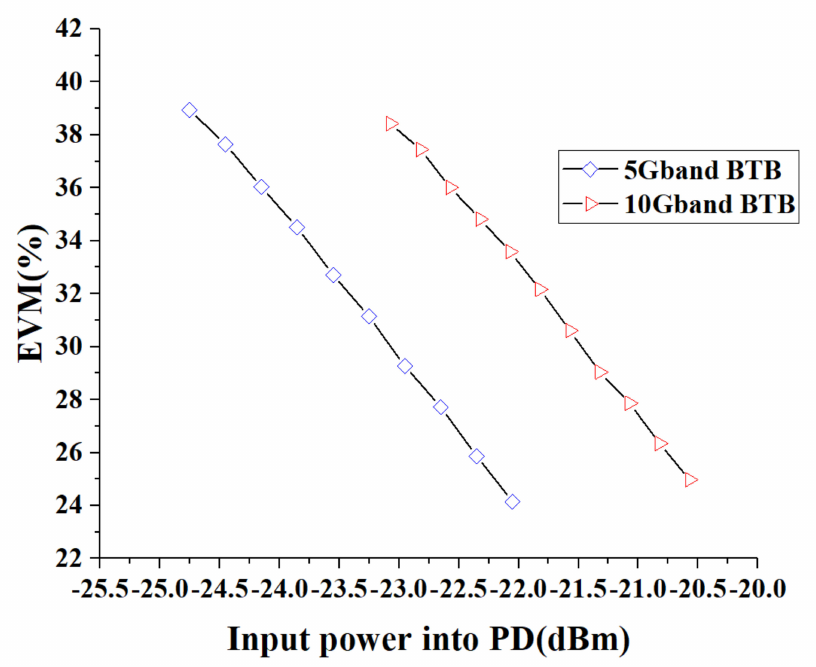
Figure 6. The measured EVM results versus launched optical power into